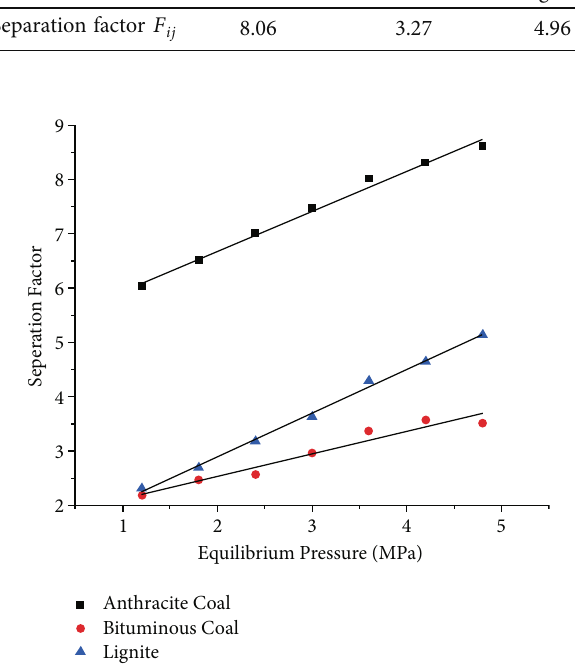
Figure 7: Separation coe ffi cients of di ff erent rank coal samples.